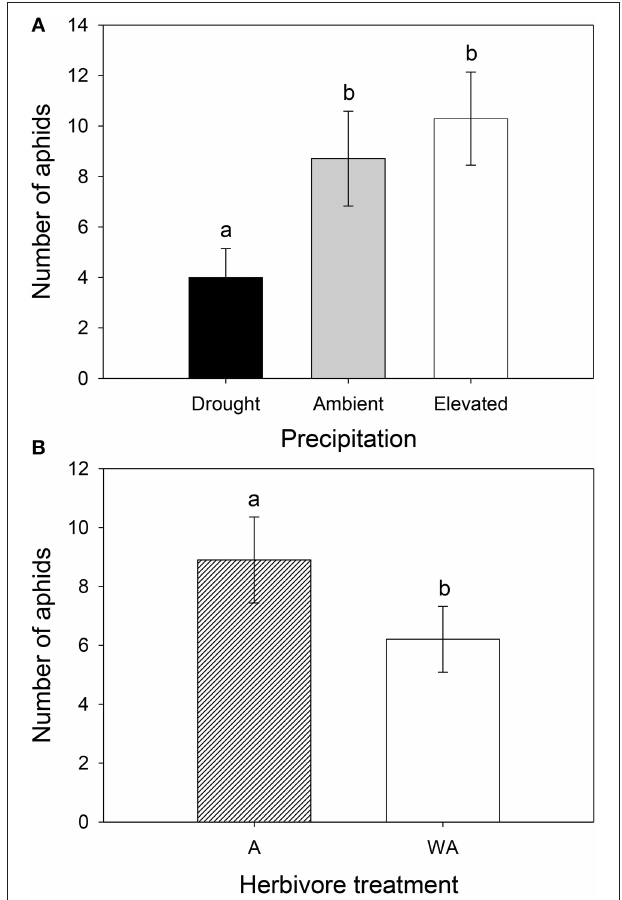
FIGURE 8 | The impacts of precipitation (A) and weevil presence (B) on the number of aphids. A had aphids alone and WA had both weevils and aphids. Mean values ( ± SE) are shown. Bars with the same letters were not significantly different ( P <